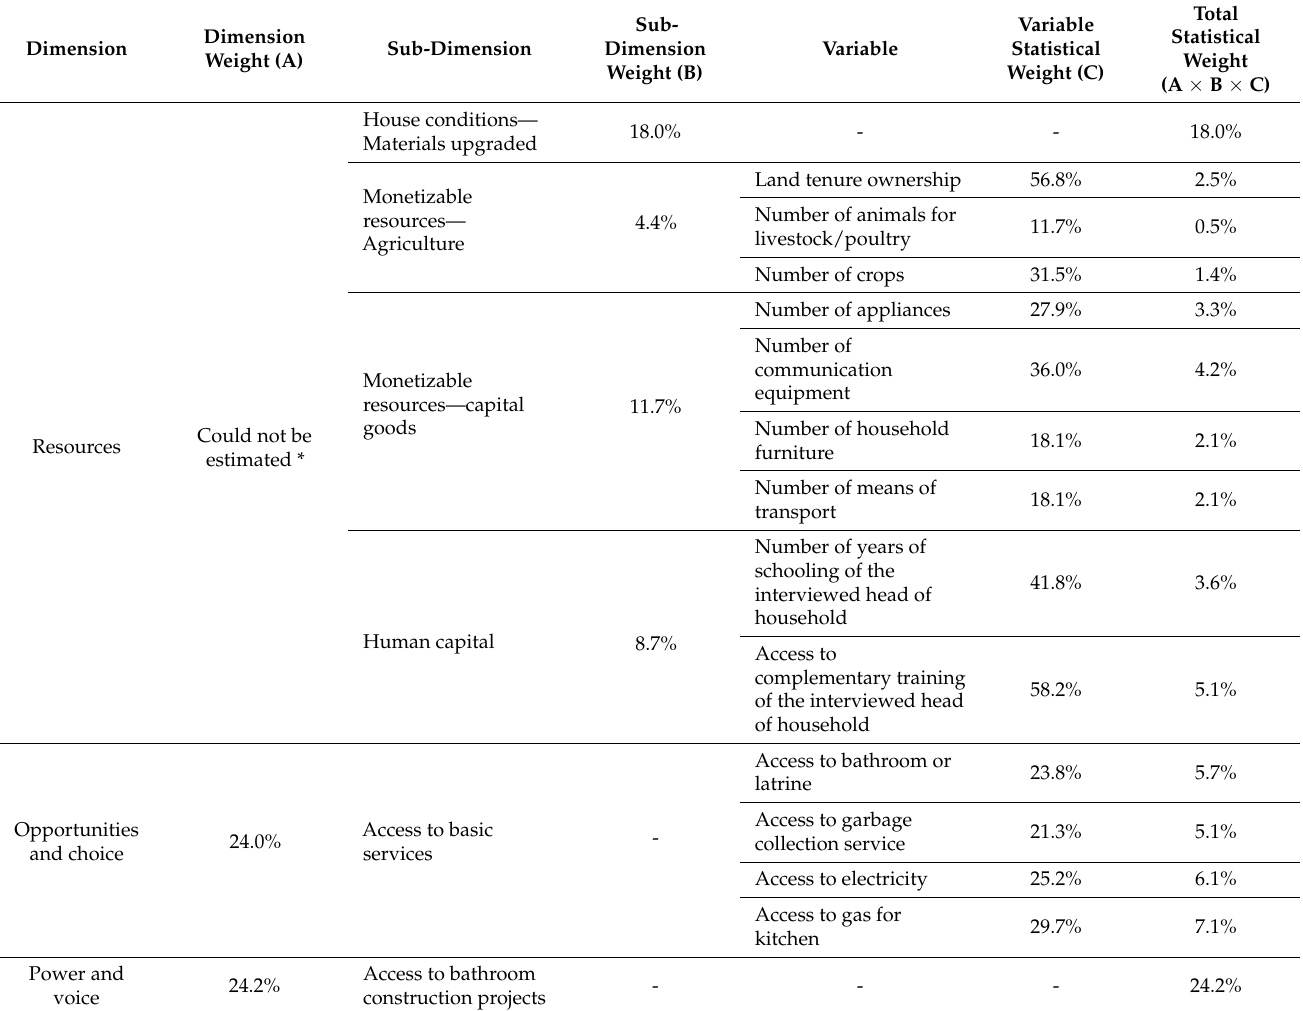
Table 5. Disaggregation of the rural